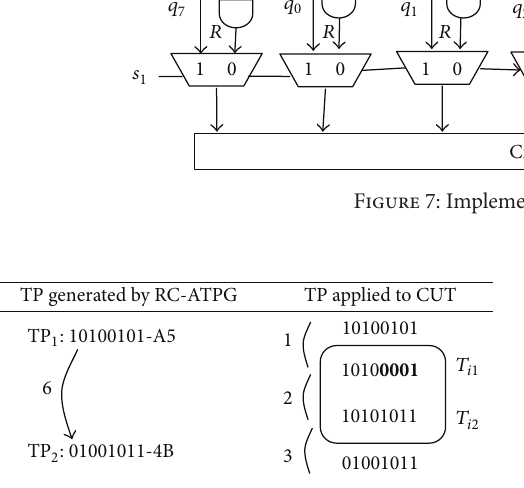
Figure 8: Generated test patterns for 8-bit CUT. TP 1 and TP 2 : consecutive test patterns; 𝑇 𝑖1 and 𝑇 𝑖2 : test vectors.